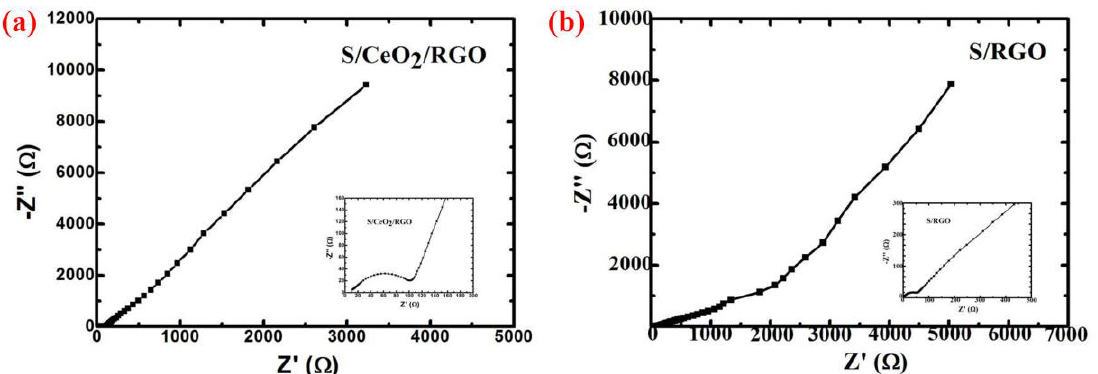
Figure 13. Electrochemical impedance spectroscopy (EIS) Nyquist plots of the ( a ) S/CeO 2 /RGO and ( b ) S/RGO electrodes.